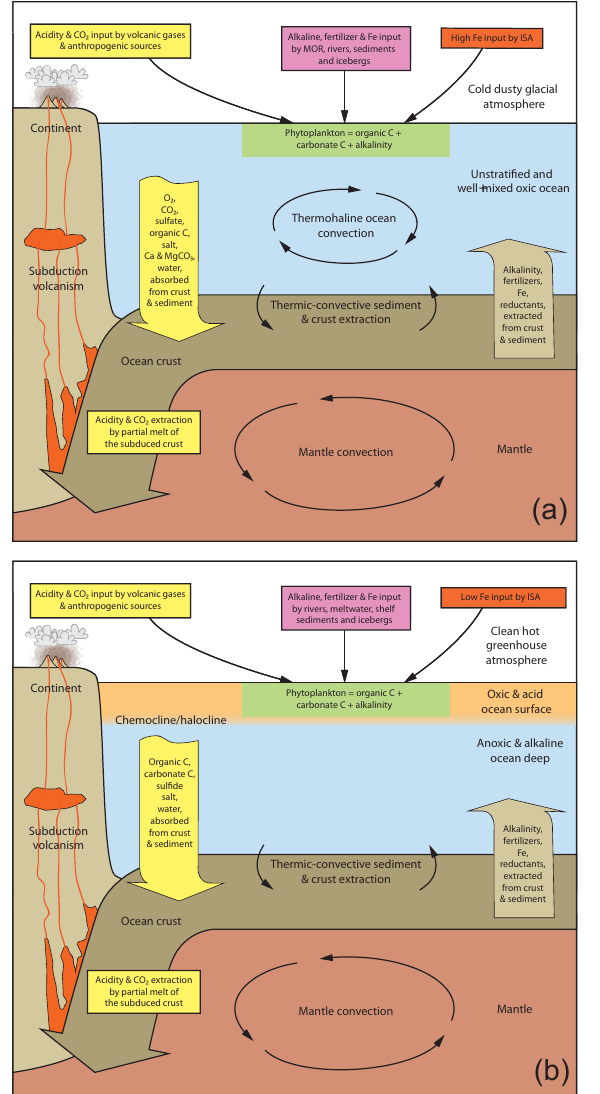
Figure 6. This figure presents the essential differences between an unstratified well-mixed ocean basin under a cold and dusty atmosphere during the cold main glacial, with low atmospheric GHG concentrations (a) and a stratified ocean basin with a meltwater layer on top of a saline ocean water layer during a warm interglacial, with a hot and dust-free greenhouse atmosphere (b) . Panel (a) : due to the unstratified well-mixed water column in Basin 6A, CO 2 and O 2 absorbed at the water surface are distributed within all parts of the basin. There are high production rates of organic carbon produced by phytoplankton in the top layer, and this carbon is oxidized on its way down to the sediment layer, with only a minor generation of organic sediment. Carbonate carbon produced by the phytoplankton becomes dissolved to a great extent within the deeper basin parts generating HCO − , CO 2 and HCO − . By cycling the basin bottom water through the alkaline bottom sediment 3 3 and ocean crust aquifer, CO 2 and HCO − become precipitated and buried as carbonate C. The recycled bottom water becomes enriched by 3 Fe fixed to organic chelators and is transported back to the surface. Due to the unrestricted downflow and transfer of CO 2 from the former surface water into sediments and into underlying base rock as carbonate carbon, the buried carbonate C exceeds the buried organic C amount. Panel (b) : an interglacial episode with high GHG levels accompanied by elevated surface temperatures generates increased meltwater and surface water runoff. Because the saline-poor water layer spreads to the saline ocean water and induces at least a regional stratification of the ocean basins water column, the production of brine-induced surface water downflow is stopped, as meltwater freezing generates neither brine nor any vertical surface water movement. This stops any down transport of absorbed CO 2 and O 2 too and generates anoxic conditions within the underlying saline layer. The anoxic saline layer becomes anoxic and alkaline by sulfate and nitrate reduction. Any phytoplankton-induced organic and carbonate litter trickles down through the anoxic and alkaline layer: CaCO 3 without dilution in the alkaline water and organic C without oxidation in the anoxic milieu. Carbonates of Ca and Mg may precipitate in small amounts at the chemocline between light acidic CO 2 saturated water and the alkaline saline layer. The carbonate precipitate then mixes with the down-falling phytoplankton-originating